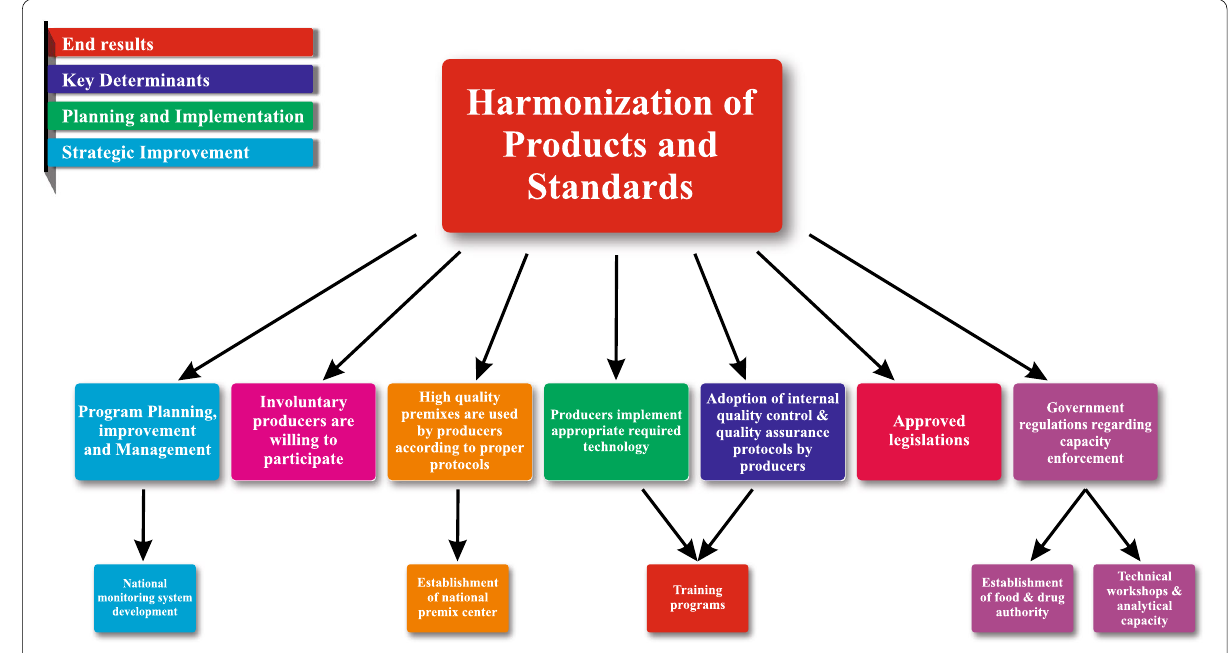
Fig. 1 Harmonization of Products and Standards for